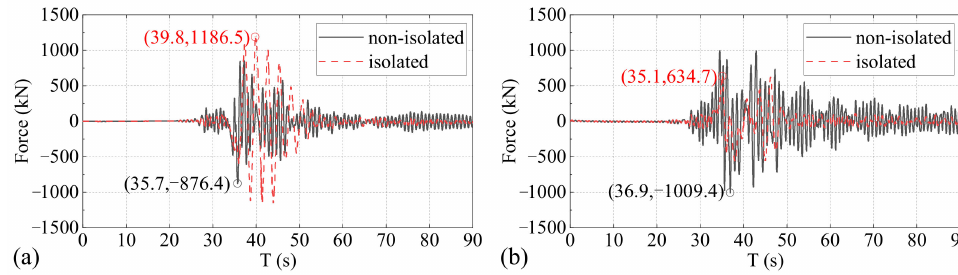
Figure 12. The shear force-time histories of pier P2. ( a ) X-direction. ( b )